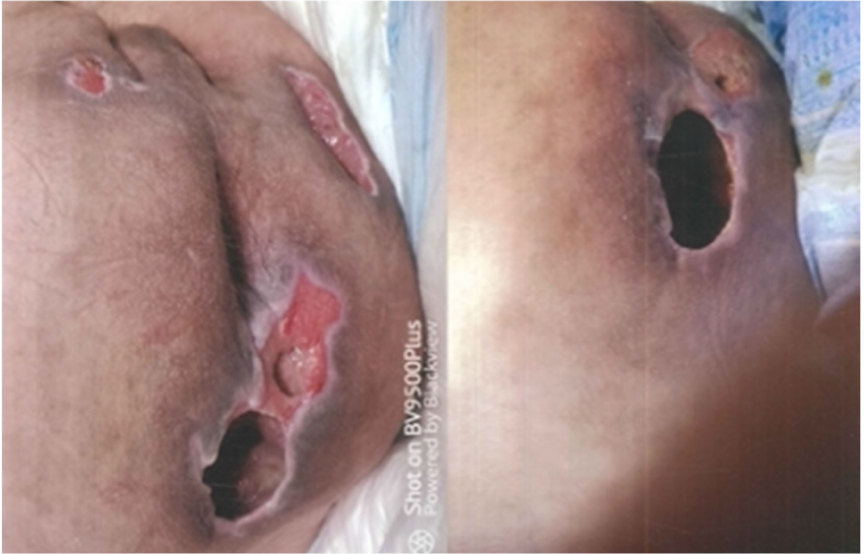
Figure 1. Situation at hospital